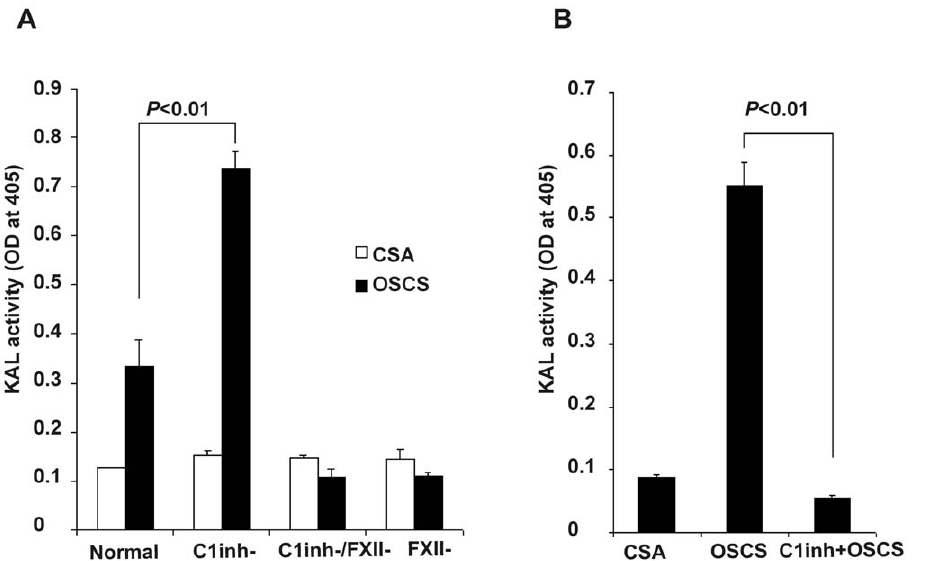
Figure 1. C1 inhibitor regulates OSCS-induced kallikrein activity. (A) Normal human plasma, plasma depleted of C1 inhibitor, plasma depleted of factor XII, and plasma depleted of both C1 inhibitor and factor XII, were incubated with chondroitin sulfate A (CSA) or over sulfated chondroitin sulfate A (OSCS). The effect of kallikrein amidolytic activity was assessed by the addition of the s-2302 chromogenic substrate. (B) OSCS- induced kallikrein activity was totally inhibited by addition of 200 m g/ml of C1 inhibitor. At least three independent experiments were completed with duplicate samples for the assay.